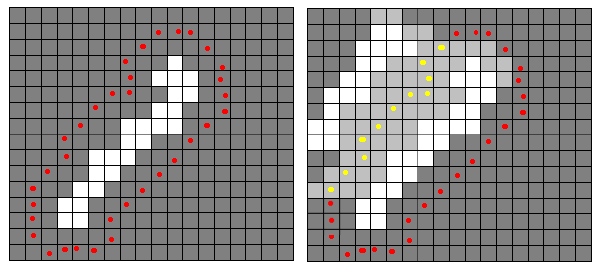
Figure 3. Left: schematic representation of an isolated contrail (white), its background (dark grey) and the pixels considered as the reference state (red). Right: schematic representation of two con- trails (white) forming a cluster (light grey). Pixels in the cluster (yellow) must be excluded and only pixels marked in red must be considered as the reference state.